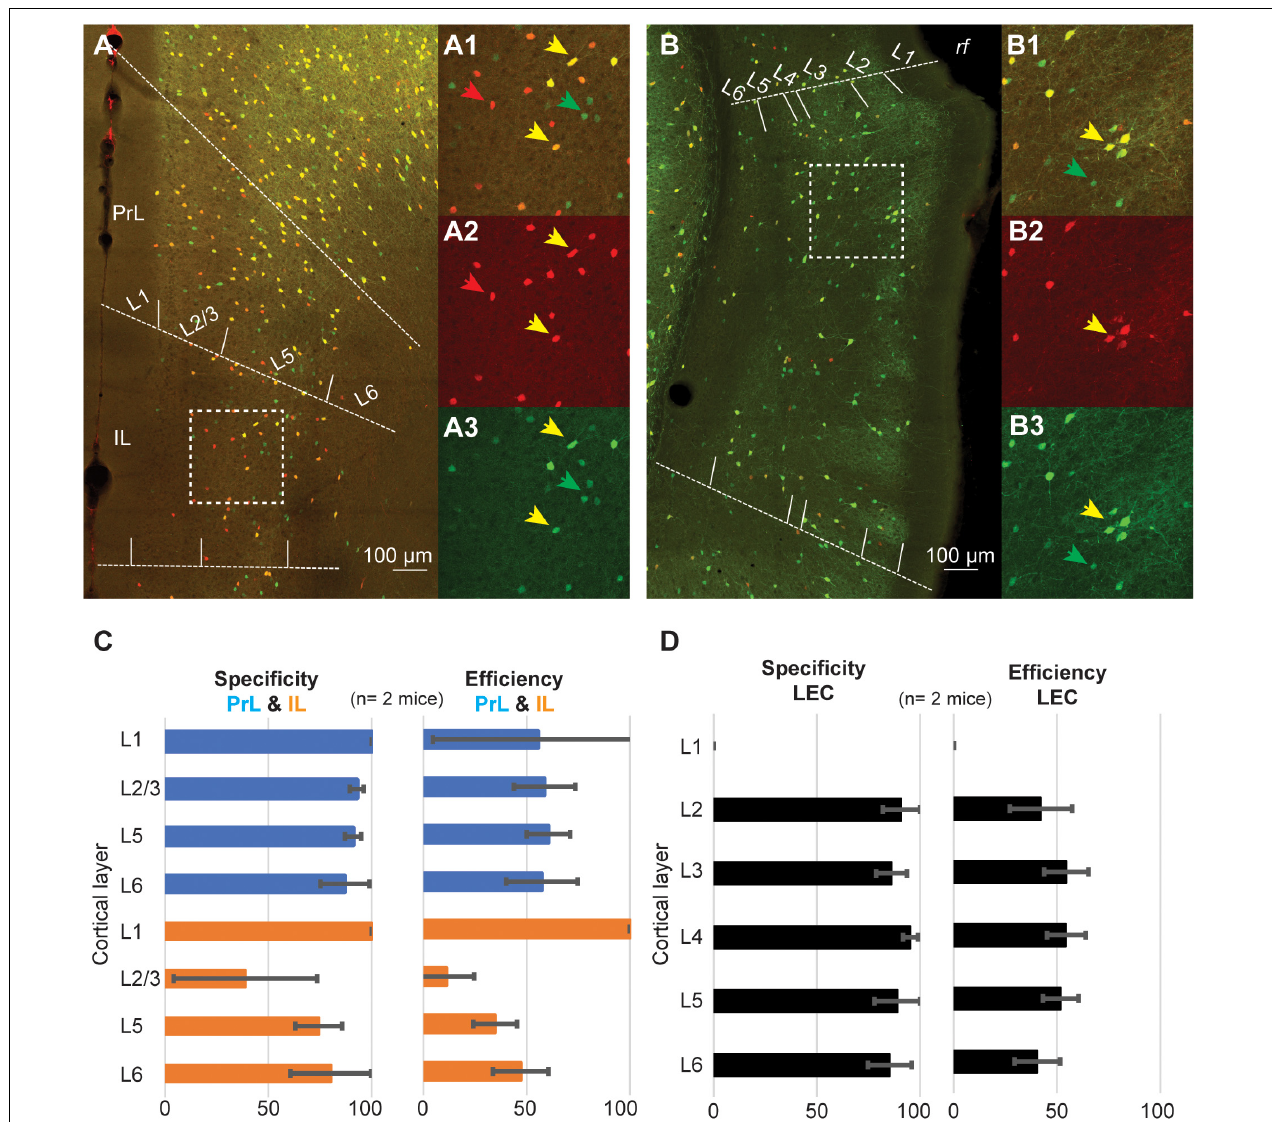
FIGURE 7 | Representative confocal stack showing the overlap of PV (green) and tdTomato (red) in PrL and IL cortex (A) , and in LEC (B) . Inserts show magnification of the areas highlighted by dotted squares in (A,B) ( A1–3 , IL; B1–3 , LEC). (C) Bar graphs showing the specificity and efficiency of the PV-IRES-Cre mouse line in PrL and IL. (D) Bar graphs showing the specificity and efficiency of the PV-IRES-Cre mouse line in